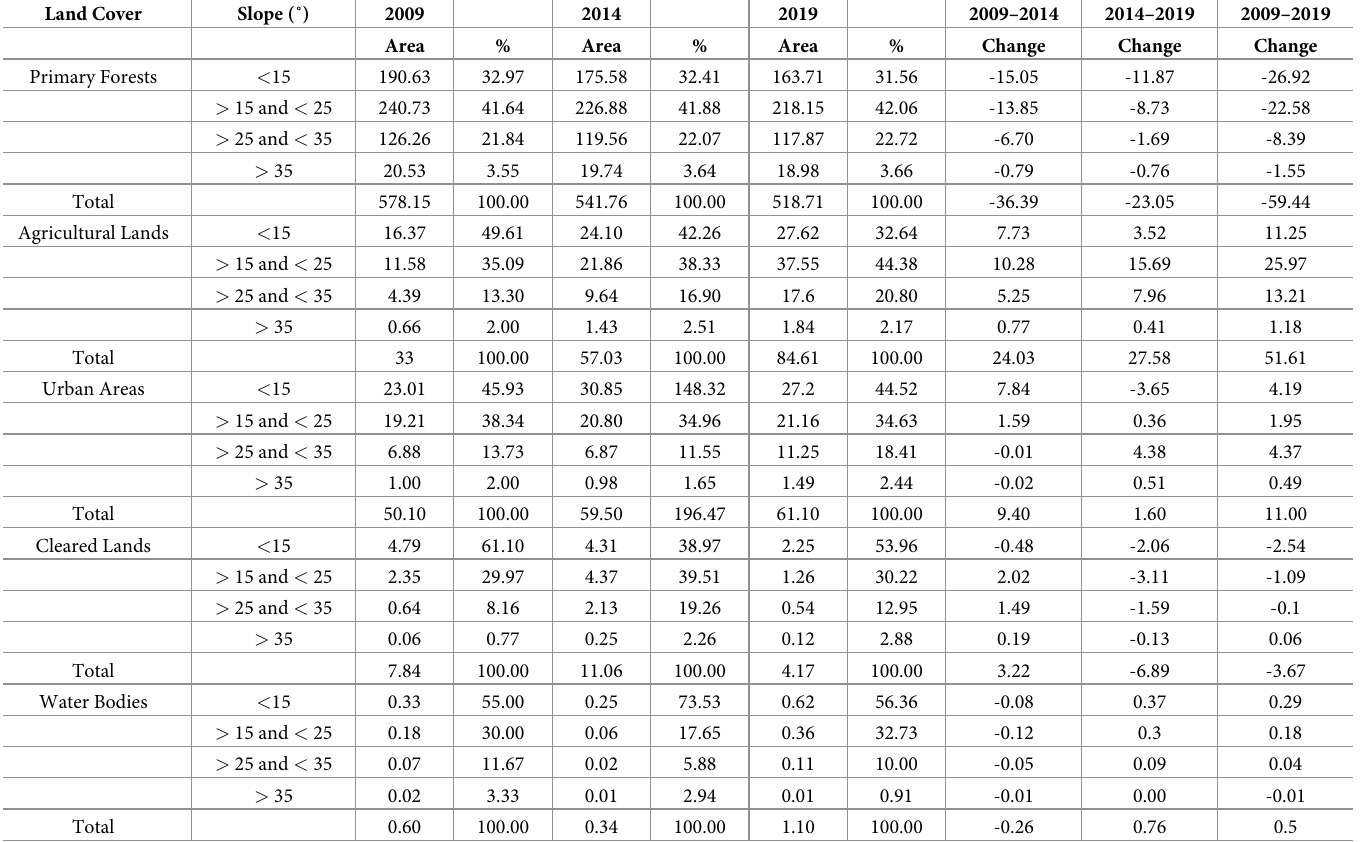
Table 7. LU/LC distribution of area and area change (km 2 ) across the slope (˚). Land Cover Slope (˚)